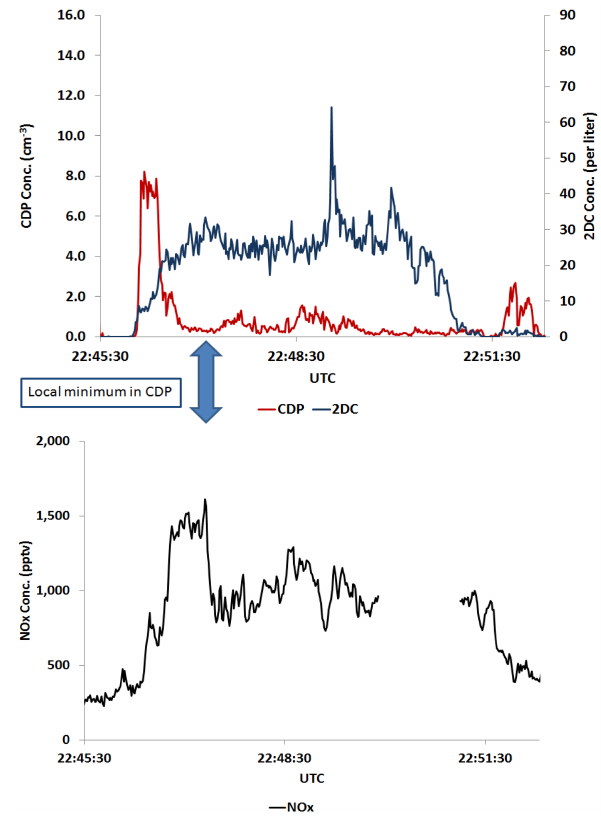
Figure 7. Concentrations from the CDP (red) and 2DC (blue) in- struments (top), and corresponding NO x concentrations (bottom) for a G-V pass through the anvil on 15 June 2012 at altitudes of 11.7 to 12.2km and temperatures of − 56.6 to − 53.5 ◦